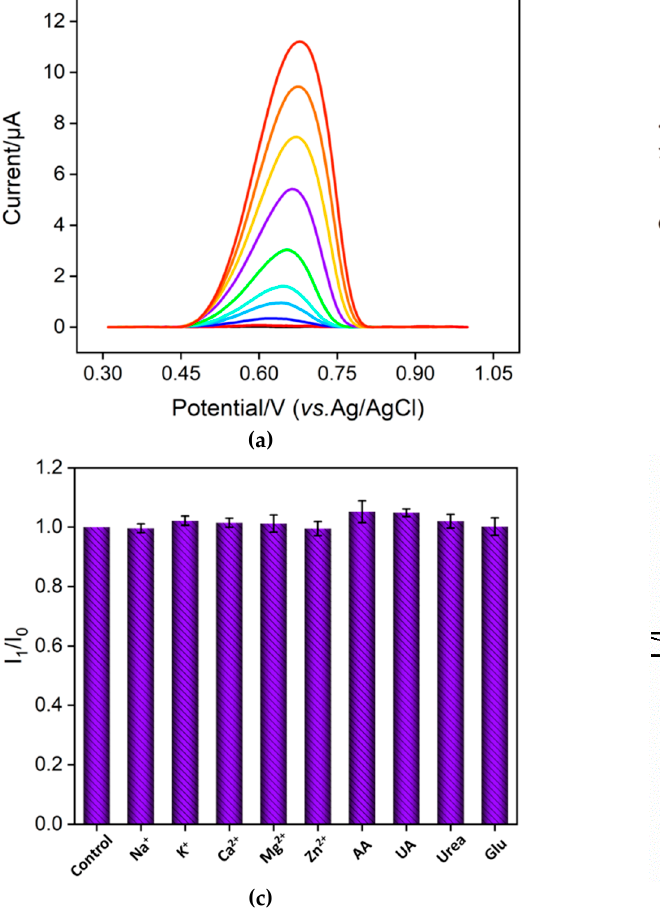
Figure 6. ( a ) DPV response of VMSF/p-3DG electrode with different concentrations of TR in PBS (0.01 M, pH 7.4). ( b ) The corresponding calibration curves. ( c ) The relative peak current ratio (I 1 /I 0 ) in presence of different interfering species. I 0 and I 1 depict the peak currents measured in TR solution (2 μ M) in the absence and presence of interfering species (100 μ M). ( d ) The relative peak current ratio (I 2 /I 0 ) obtained in successive scan in urine (diluted by a factor of 10) containing TR (10 μ M). I 0 and I 2 depict the peak currents measured at the indicated time. Table 1. Comparison of the preformation for detection of TR using different electrochemical sensors. Electrode